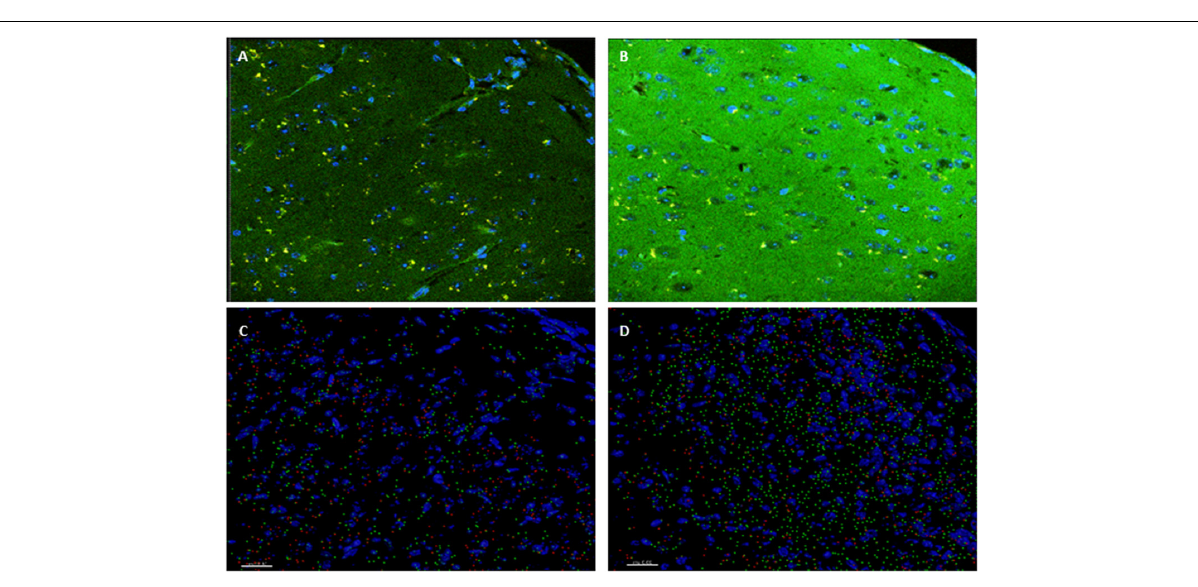
FIGURE 5 | PH-Tau-Tg mice have elevated levels of expression of activated insulin receptor and glucose transporter. (A) Control and (B) PH-Tau-Tg are representative images of a 30 µ m cryosection probed with anti-p(Ser)-IRS1 (green) and anti-Glut 4 (red) showing the pattern and intensity of immunoreactivity in the cortex. DAPI (blue) was included in the mounting medium and used for nuclear localization. (C) Control and (D) PH-Tau- are Images that depict Imaris reconstructions of the z-stacks obtained with a confocal microscope of the same regions shown in (A,B) . Cortex from PH-Tau-Tg mice shows a significant ( p < 0.05) increase in immunoreactivity for p(Ser)-IRS1 and Glut 4. Scale bar = 20 µ